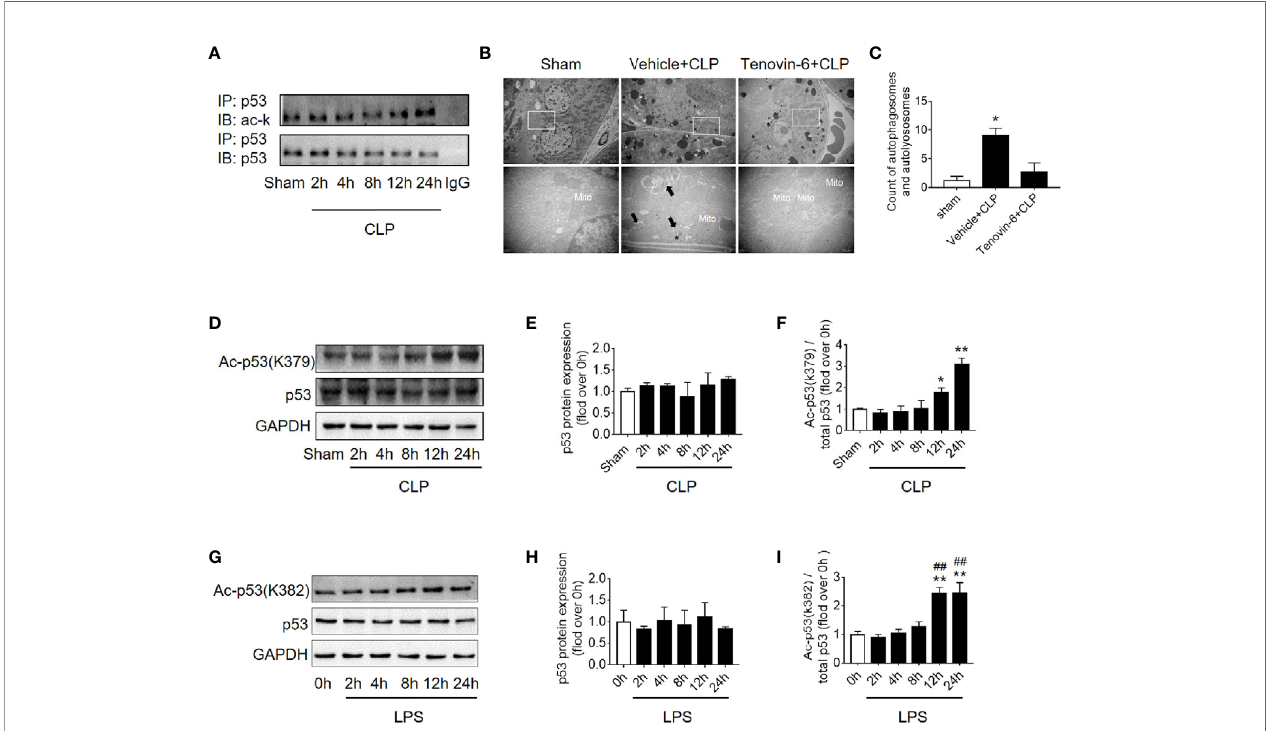
FIGURE 5 | p53 acetylation following CLP/LPS-induced sepsis. (A) Protein expression and acetylation levels of p53 based on p53 immunoprecipitation (IP) from the kidney cortex of CLP-induced septic mice. IB, immunoblotting; ac, acetylation. (B) p53 activation of autophagy in the renal cortex of CLP-induced septic mice. Tenovin-6 was used to upregulate p53 acetylation. Black thick arrows: autophagosomes or autolysosomes; Mito: mitochondria; upper panel: magni fi ed ×7,000; lower panel: magni fi ed ×40,000. (C) Semi-quantitative analysis of autophagy. The numbers of autophagosomes and autolysosomes in renal epithelial cells were calculated in 20 randomly selected fi elds. * p < 0.05 vs. sham group. (D) Levels of total protein expression and acetylated p53 (ac-p53) at lysine site K379 in the kidney cortex of CLP-induced septic mice. (E, F) Densitometric analyses of the levels of p53 protein expression and acetylation (ac-p53) at lysine site of K379 in the kidney cortex of CLP-induced septic mice. * p < 0.05, ** p < 0.01 vs. sham group; n = 3-4. (G) Levels of total protein expression and acetylated p53 (ac-p53) at lysine site K382 in LPS-induced HK-2 cells. (H, I) Densitometric analyses of the levels of p53 protein expression and acetylation at lysine site K382 in LPS-induced HK-2 cells. ** p < 0.01 vs. the 0 h group; ## p < 0.01 vs. the 8 h group; n = 4. CLP, cecal ligation and puncture; LPS,